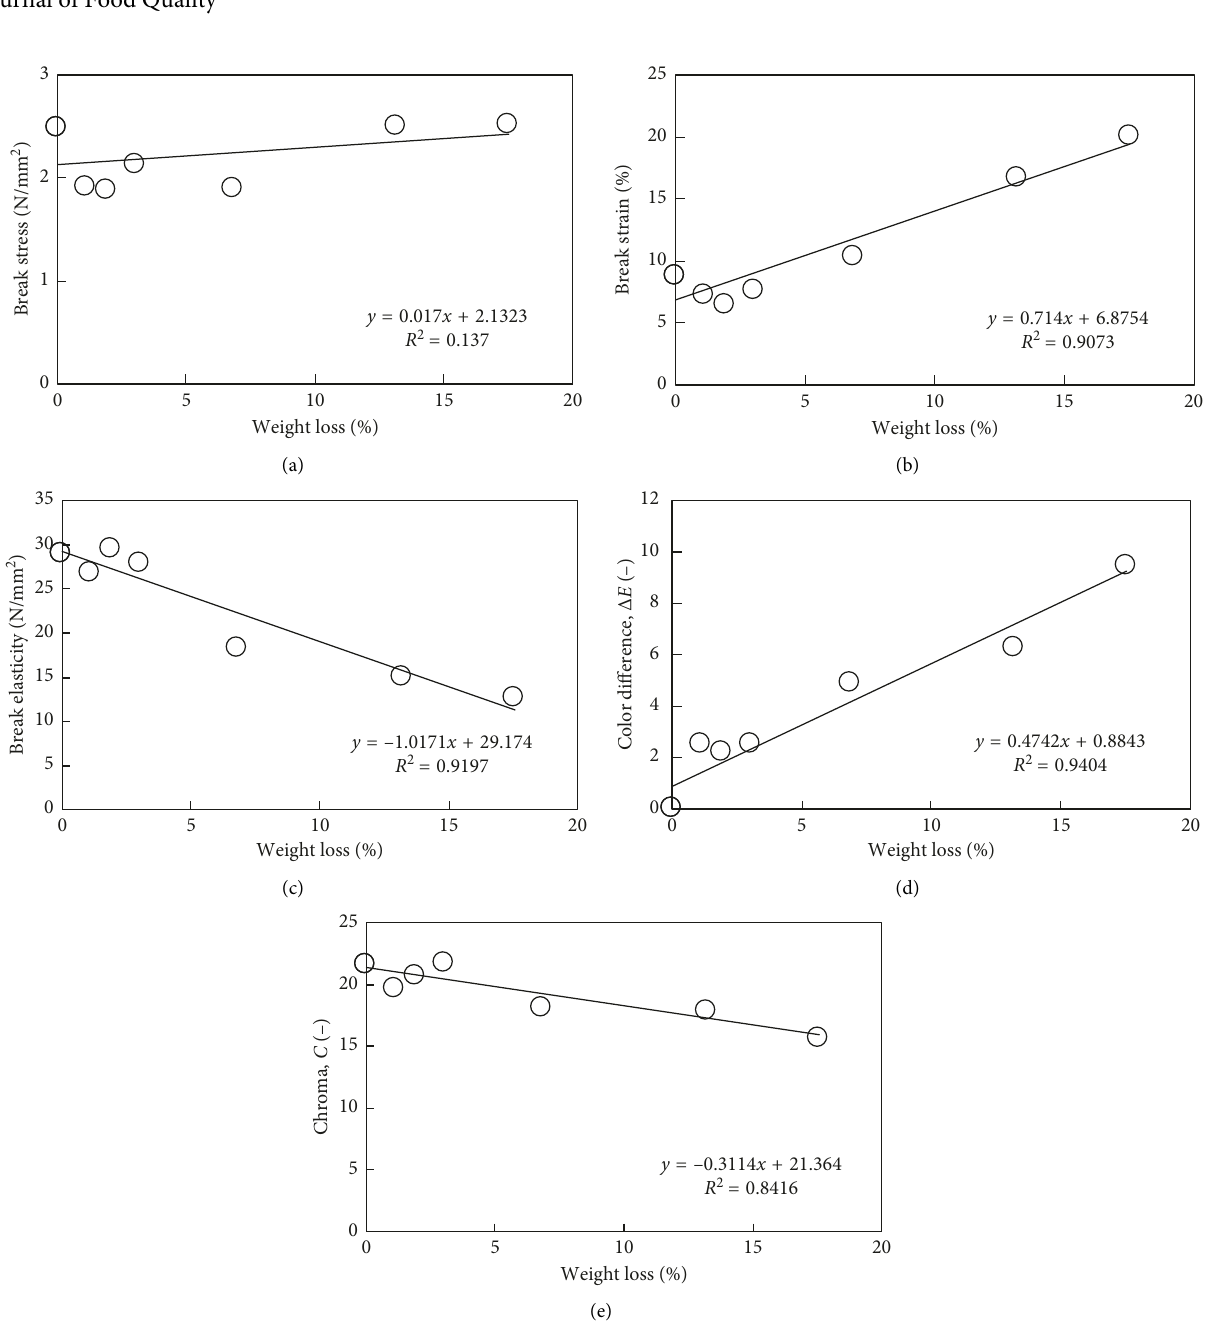
Figure 4: The relationships between the weight loss and mechanical or color properties of “Shine Muscat” fruit and the estimation equations of them: (a) breaking stress; (b) breaking strain; (c) breaking elasticity; (d) color difference; (e)